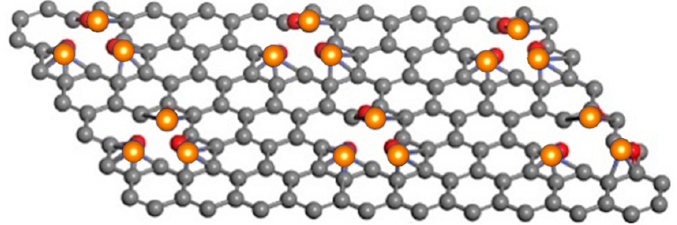
Figure 5. The sketch of experimentally fabricated oxygen stabilized Co single-atom catalyst on graphene. C in grey, Co in orange and O in red.